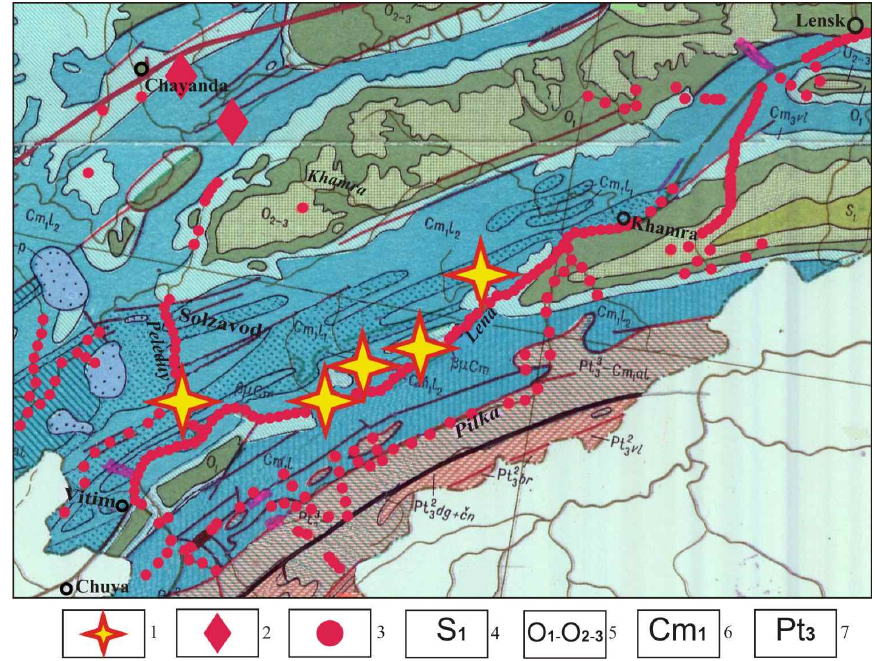
Figure 4. The proposed objects of gold-bearing hydrothermal-metasomatic formations of the Baikal- Patom thrust belt (Pilkinsky thrust), which caused the formation of placers in the basin of the middle Lena River on the section of the Vitim-Hamra rivers: 1—supposed ore sources; 2—ore occurrences; 3—stream sediment sample), containing gold. Deposits: 4—Silurian; 5—Ordovician; 6—Cambrian; 7—Upper Proterozoic. The scheme is based on the map of the gold content of Western Yakutia, 2001, scale 1: 1,500,000.